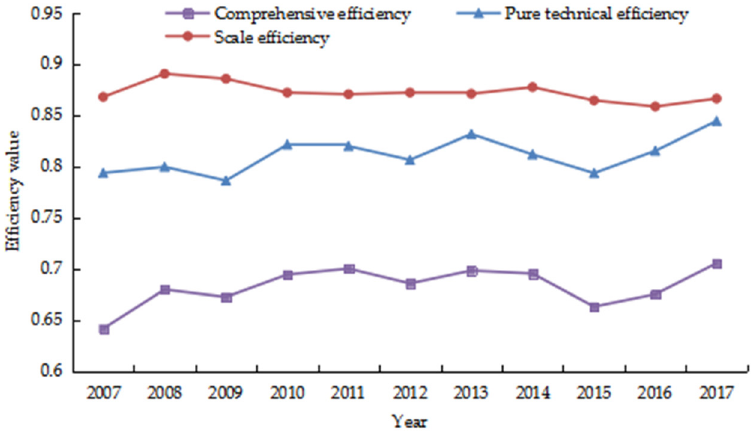
Figure 1. The overall change trend of carbon emission efficiency in China’s tourism industry.